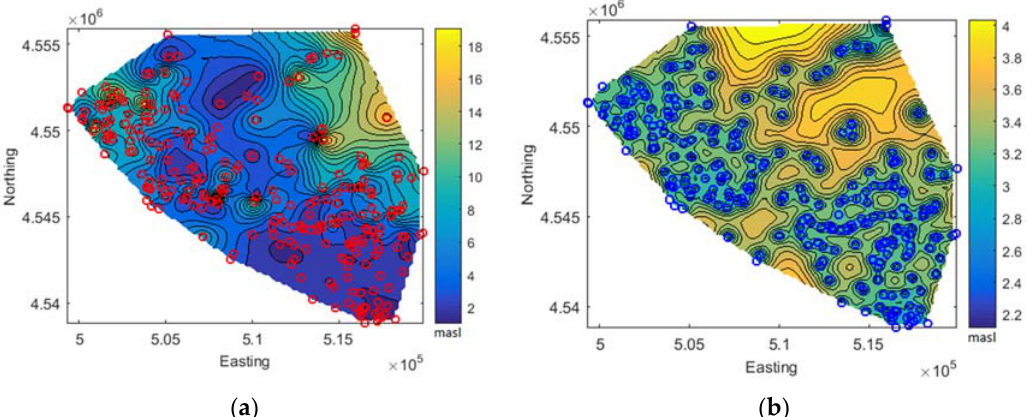
Figure 2. ( a ) Contour map of estimated hydraulic head values in the study area, using RK (red circles donate location of the 250 wells); ( b ) Contour map of estimated hydraulic head standard deviation using RK (blue circles denote location of 250